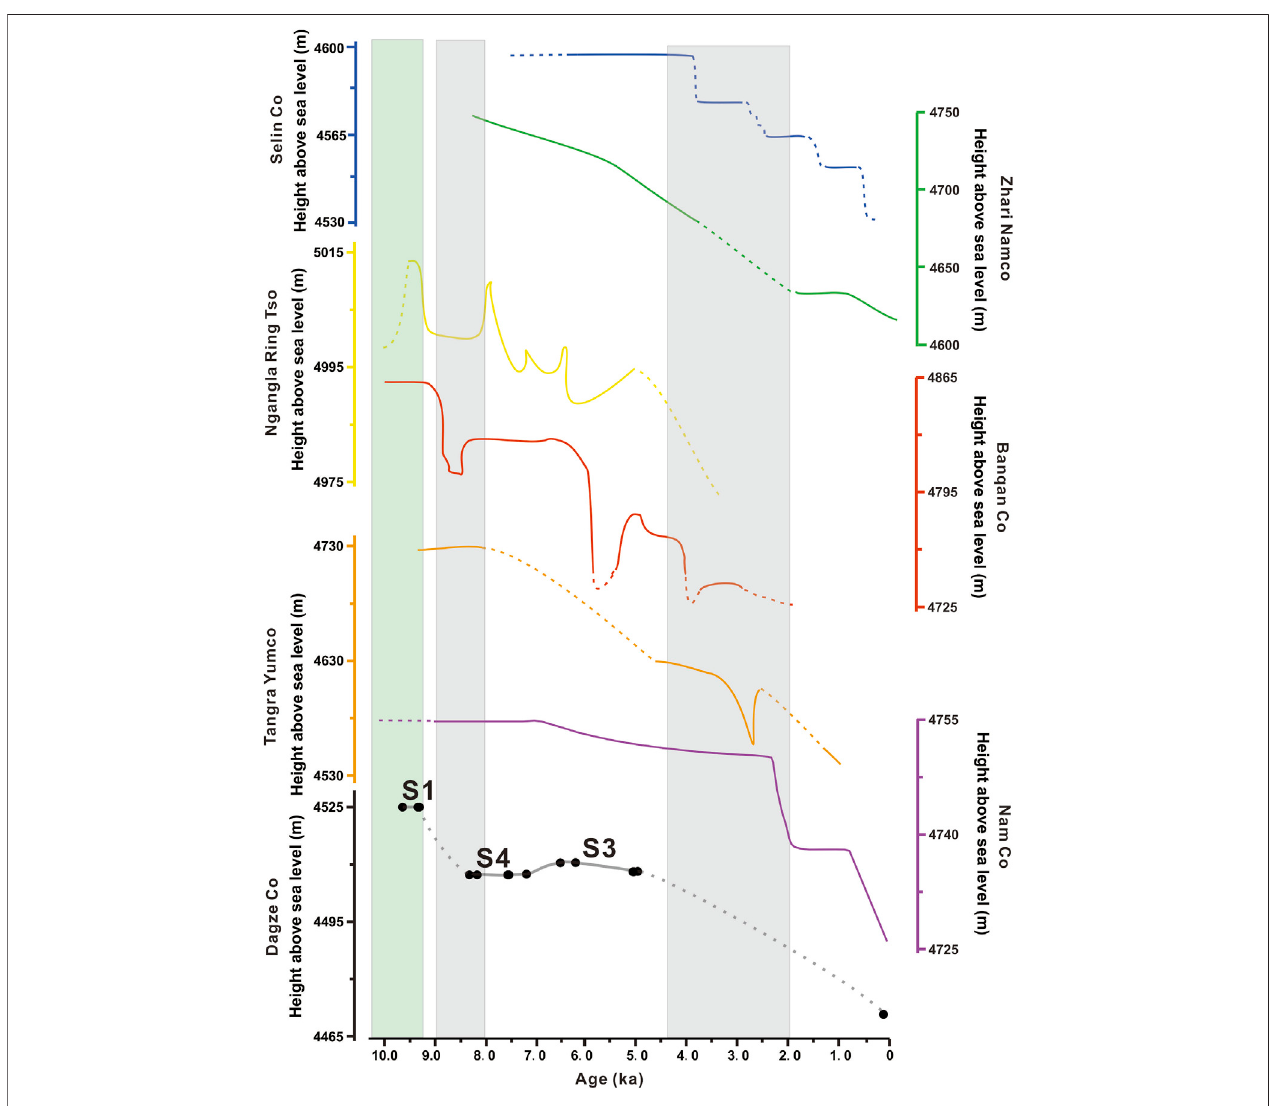
FIGURE5| ComparisonoflakelevelchangesinDagzeCowiththoseofotherlakesinsouthernplateauintheHolocene:SelinCo(Shietal.,2017;Houetal.,2021), Zhari Namco (Chen et al., 2013), Ngangla Ring Tso (Huth et al., 2015), Banqan Co (Hudson et al., 2015), Tangra Yumco(Ahlborn et al., 2015), and Nam Co (Zhou et al., 2020; Huang et al.,